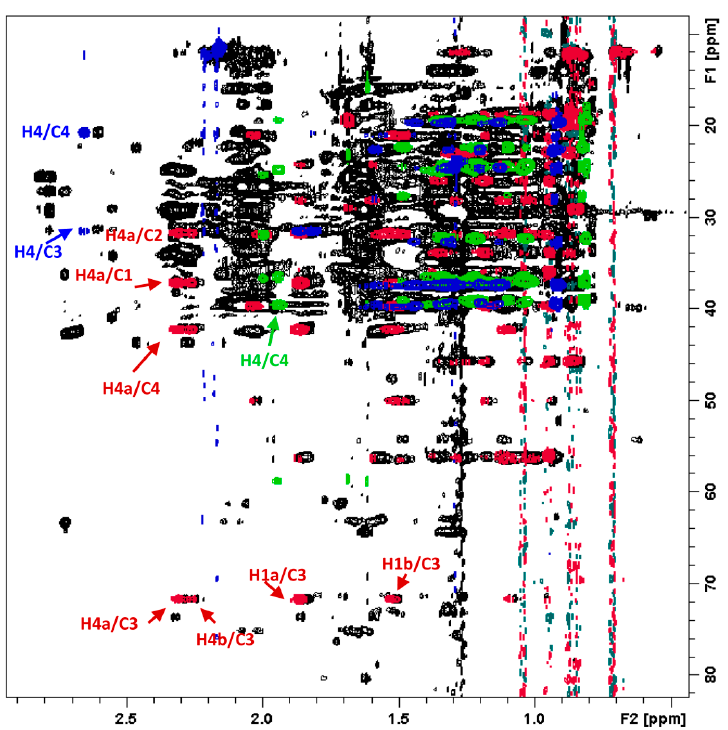
Figure 5. Expanded region of the superimposed 2D 1 H- 13 C HSQC-TOCSY NMR spectra of N. variegata (black signals), β -sitosterol (red signals), phytol (green signals) and α -tocopherol (blue signals). Selected crosspeaks are assigned. Complete assignments are presented in Tables S1–S3. Notice that the characteristic signal patterns of the pure standard compounds matches the corresponding signals of the same compounds present as part of mixture comprising the extract of N. variegata .